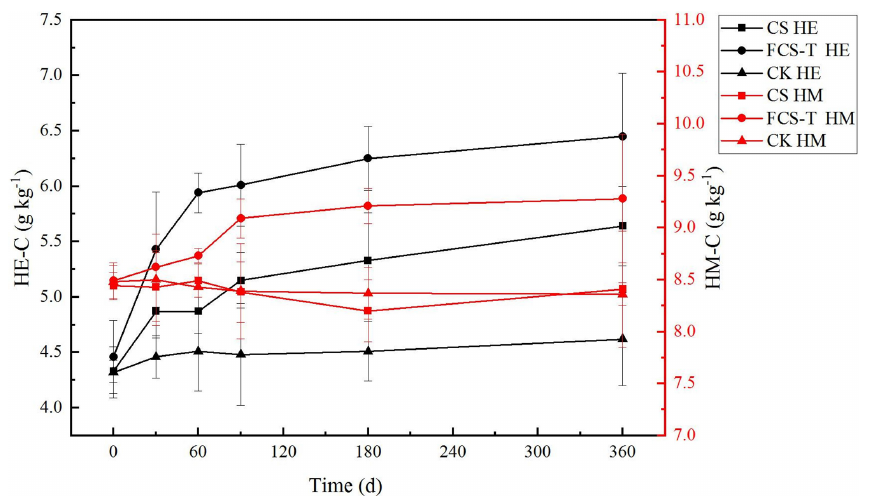
Figure 4. The carbon content of humus extracted (HE-C) and humin (HM-C) of the three different treatments during the 360d period. The error bar shows the standard deviations of triplicate averages. CS, corn straw returned to the field; FCS-T, fermented corn straw treated with T. reesei returned to the field; CK, blank control